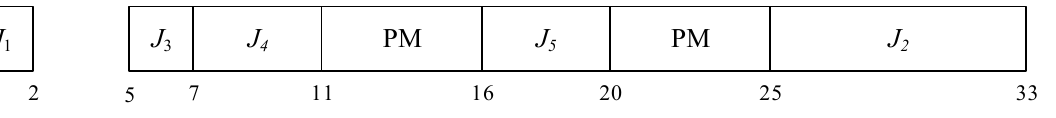
Figure 2. Gantt chart obtained by FF method.